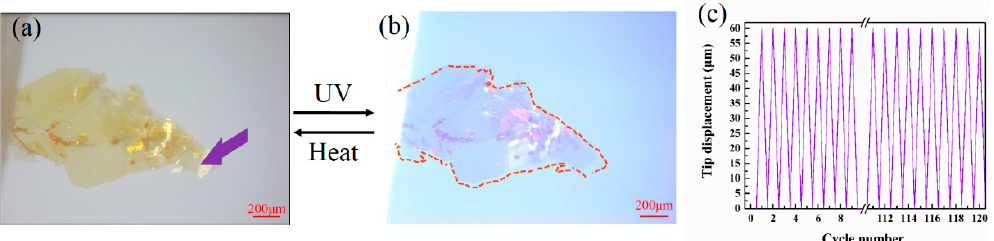
Figure 4. Photoinduced reversible bending of the plate-like 6cazpy crystal (1592 µ m × 746 µ m × 2 µ m) at room temperature. ( a ) Before and ( b ) after 365 nm UV irradiation (480 mW / cm 2 ) and the red dashed line is the original position of crystal. UV irradiation was carried out from right front on the image (indicated by the purple arrow). ( c ) Graph shows the repeatability of the reversible bending with as many as 120 cycles.